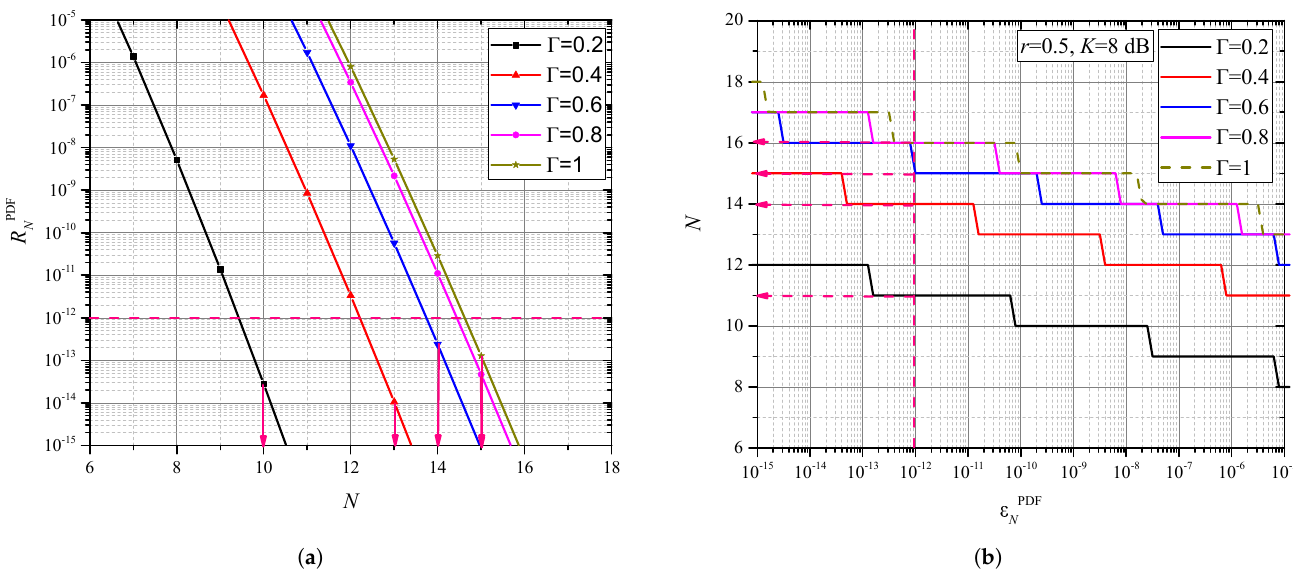
Figure 6. Effect of parameter Γ on accuracy of evaluating PDF: ( a ) upper bound for truncation error vs. number of terms in summation; ( b ) required number of terms vs. truncation